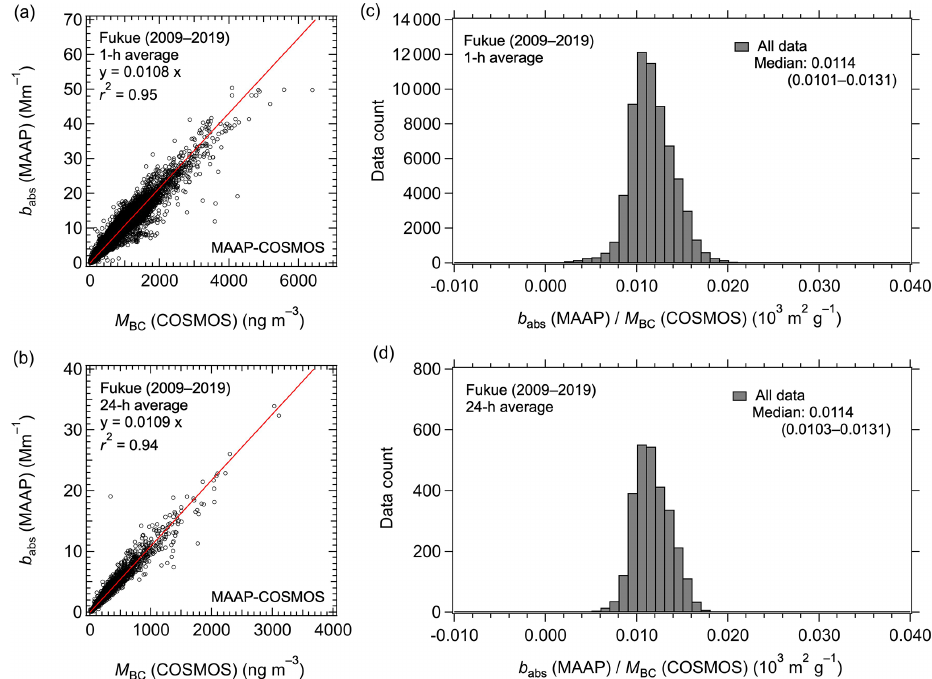
Figure 13. Correlations of M BC (COSMOS) and b abs (MAAP; λ = 639nm) from April 2009 to May 2019 at Fukue for (a) 1h averaged and (b) 24h averaged data. The solid red lines are the least-squares regression forced through the origin. (c, d) Corresponding histograms of b abs (MAAP) /M BC (COSMOS)